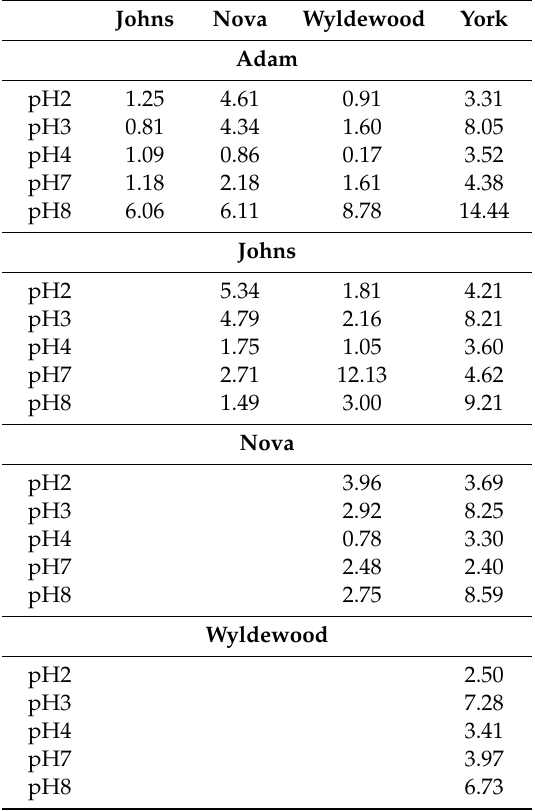
Table 4. Mean ( n = 3) color di ff erences ( ∆ E) of the extracts from di ff erent cultivars of fully-ripe fruits at pH 2–9. Johns Nova Wyldewood York